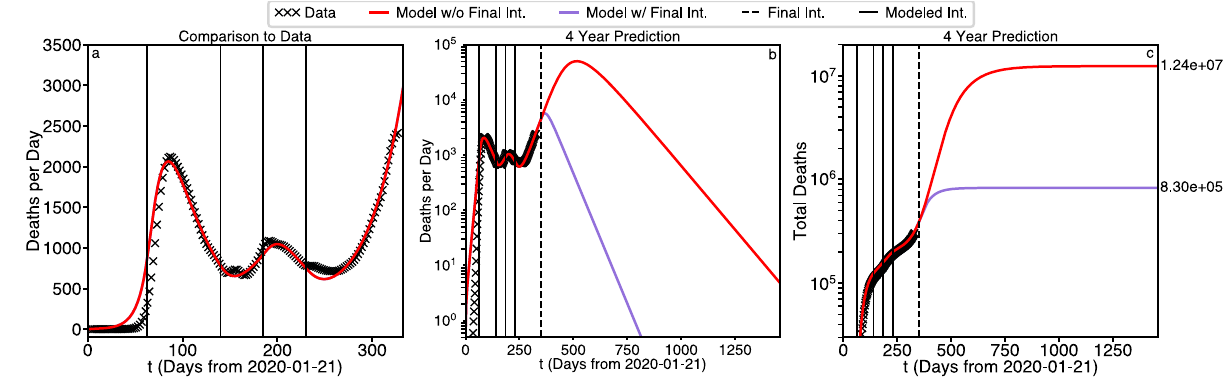
Figure 3. Best fit to deaths per day and total deaths, with and without a final dashed line. Model parameter are shown in Table 1. Critically, we note that with a final intervention at day 350 (of comparable parameters to previous interventions) the deaths per day (purple curve) dips under 1 death per